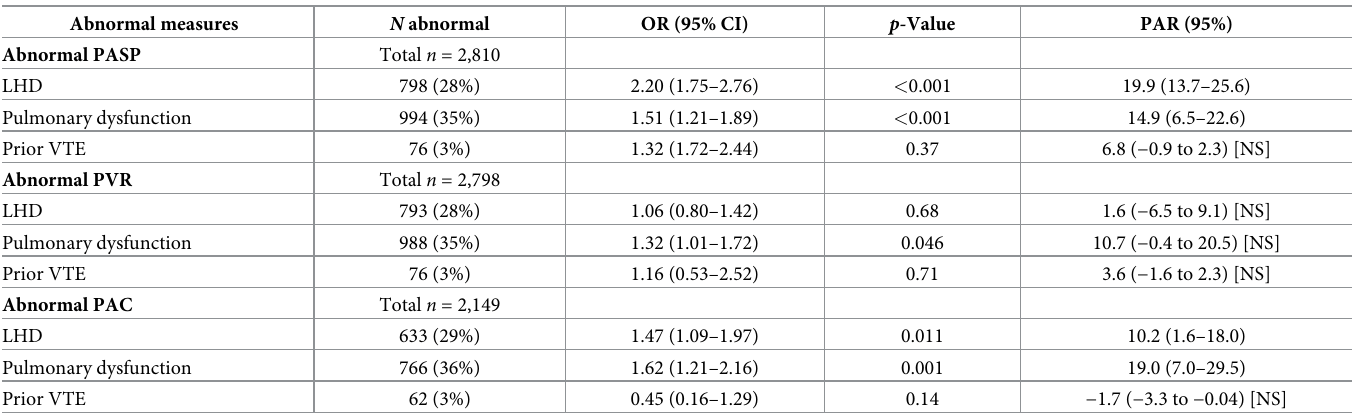
Table 2. Prevalence of LHD, pulmonary dysfunction, and VTE and their association with abnormal PASP, PVR, or PAC. Abnormal measures